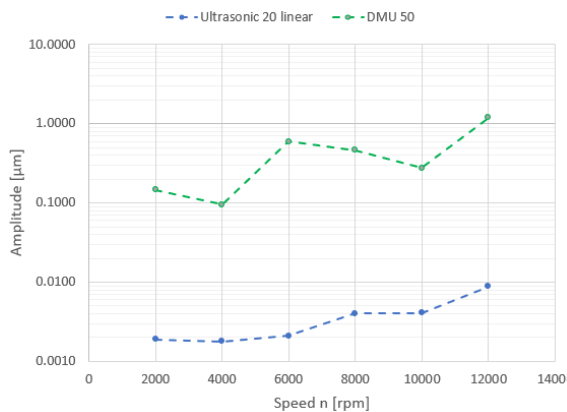
Fig. 7. Comparison of operational deflection shape of “Ultrasonic 20 linear” and “DMU